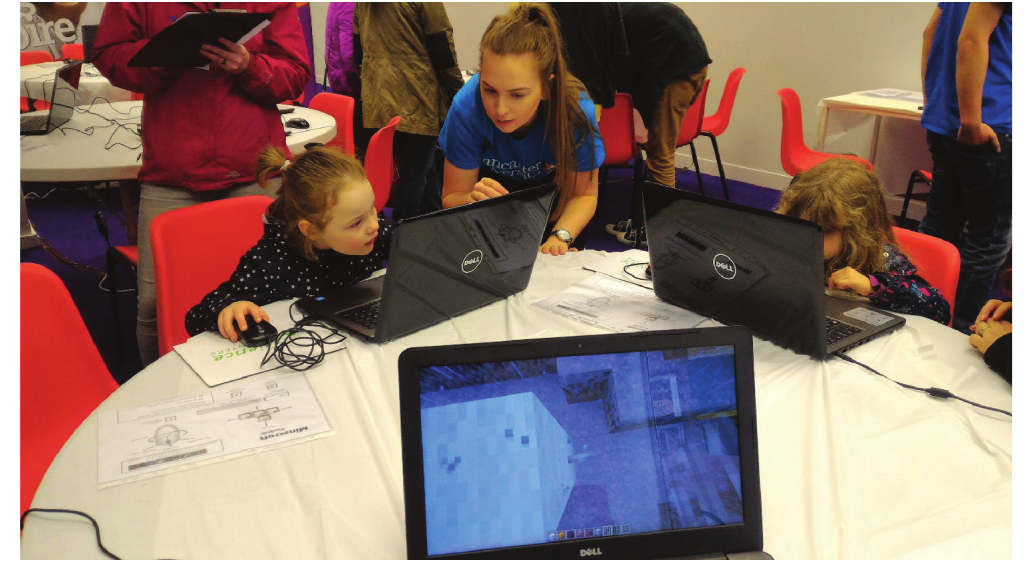
Figure 1: Children participating in a Science Hunters session, building parasites at Campus in the City (2018), with support from Science Hunters volunteer Amber